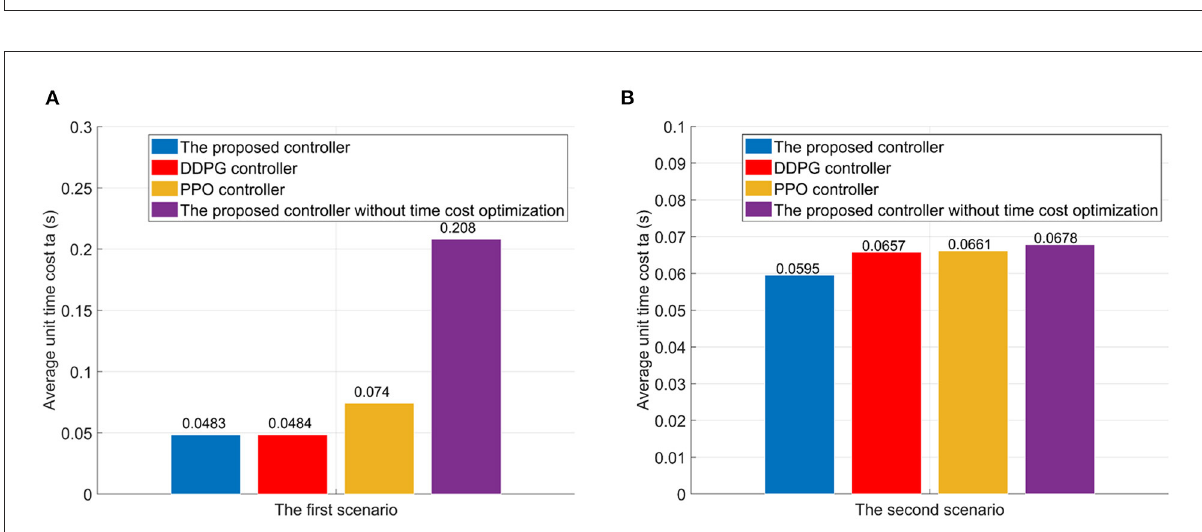
controllers. According to Figure 12, the average reliable rate of the proposed controller for the first scenario is